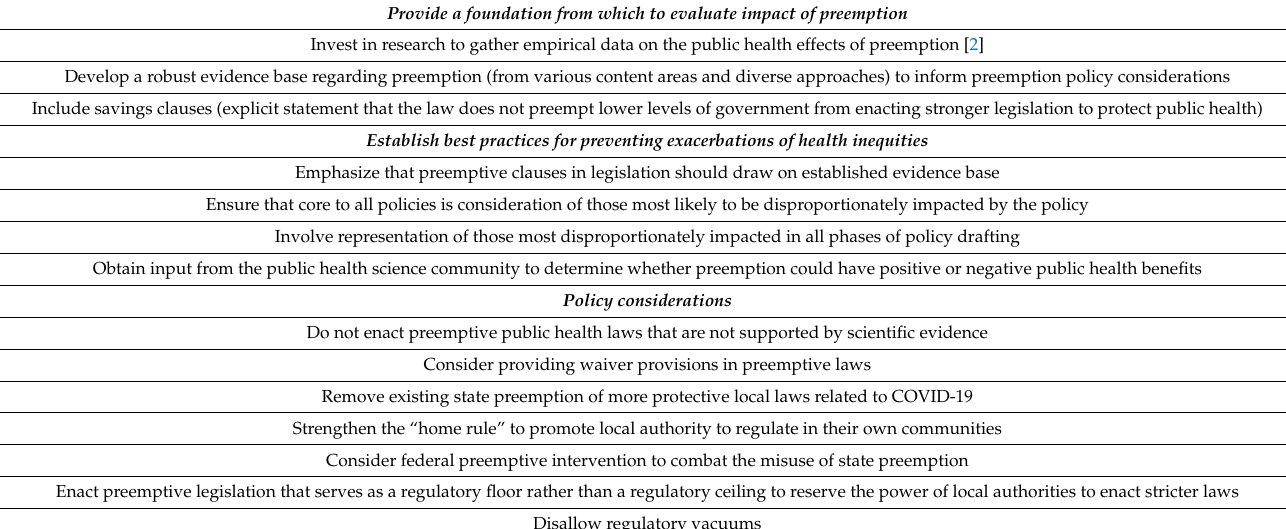
Table 2. Recommended steps to improve the effects of preemption on public health and